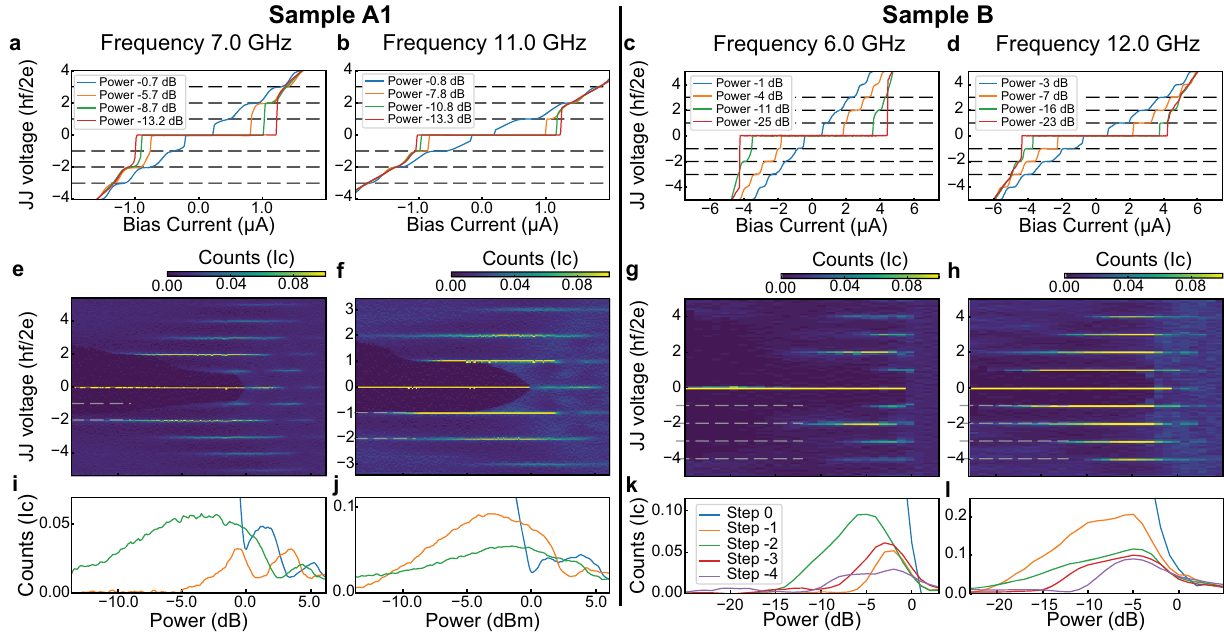
Fig. 2 Voltage – current characteristic in the presence of microwave radiation. a – d Histogram of the Josephson junction voltage as a function of the microwave power ( e – h ) and width of the Shapiro steps as a function of the microwave power ( i – l ) for devices A1 and B at two different frequencies for each device. In both the histogram and the plot of the width of each step, counts are expressed in unit of the critical current of the junction in the absence of the microwave drive. In both devices, while at high frequencies all Shapiro steps are visible, at low frequency and low power, the fi rst step appears to be strongly suppressed. The microwave power is normalized to the power required to observe the vanishing of the critical